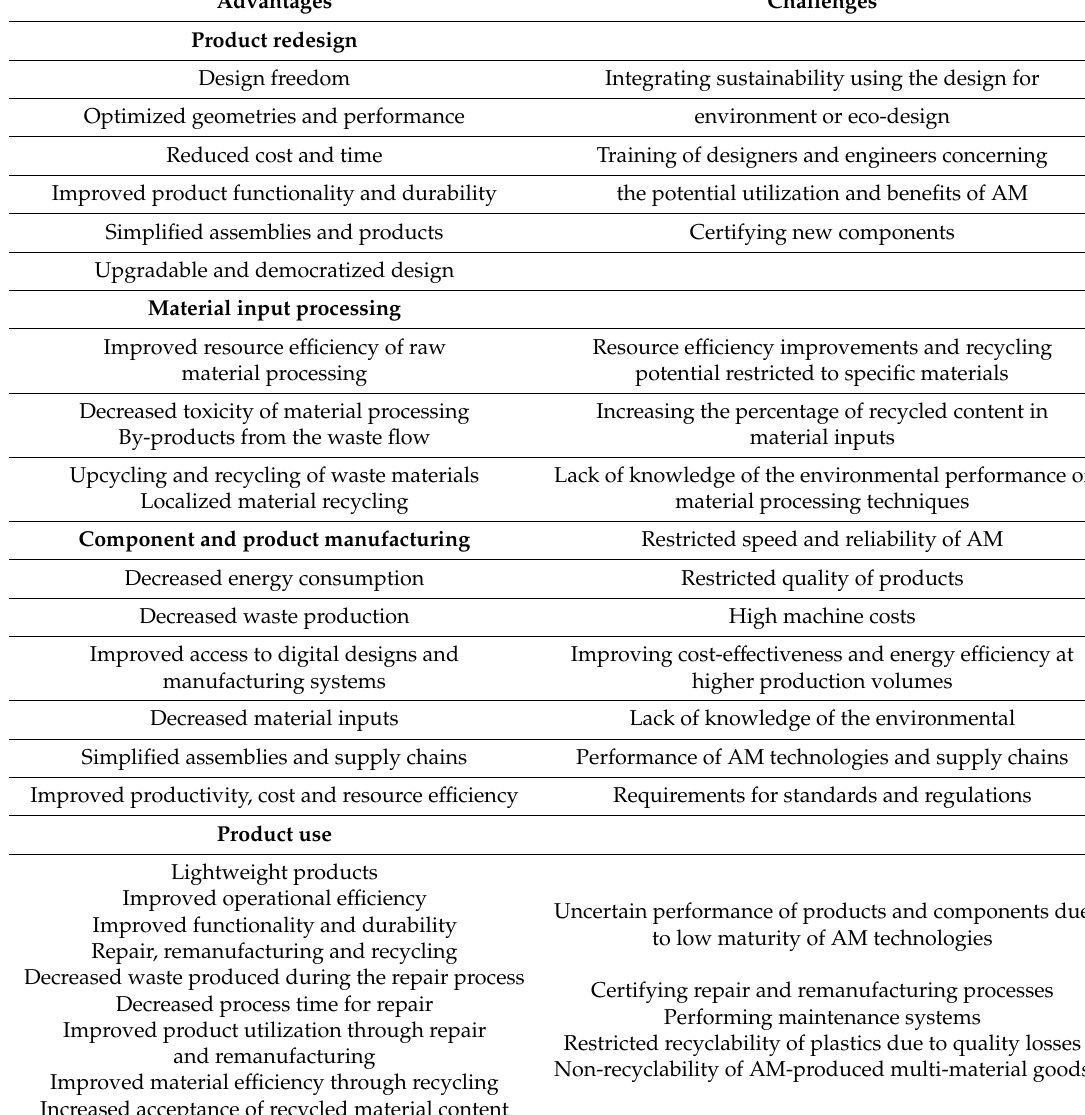
Table 3. Summary of benefits and challenges of sustainable AM process